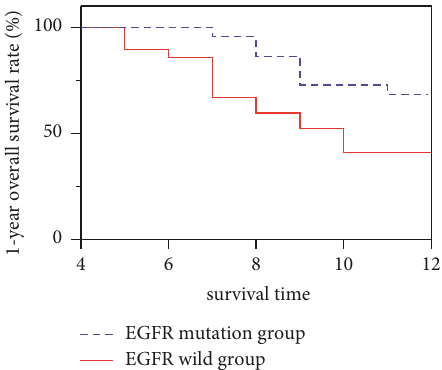
Figure 4: Survival curve associated with EGFR gene